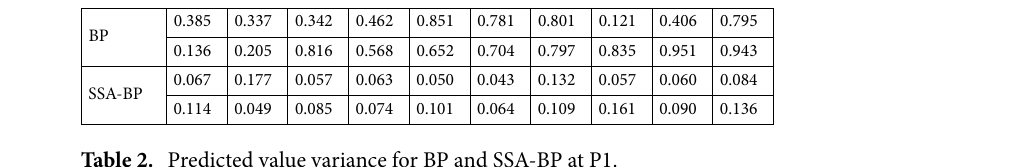
Table 2. Predicted value variance for BP and SSA-BP at P1.